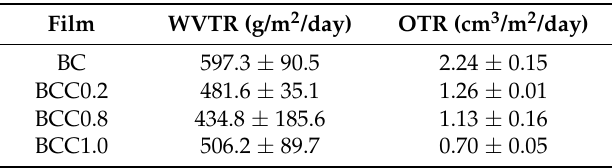
Table 1. WVTR and OTR of BC and BCC film